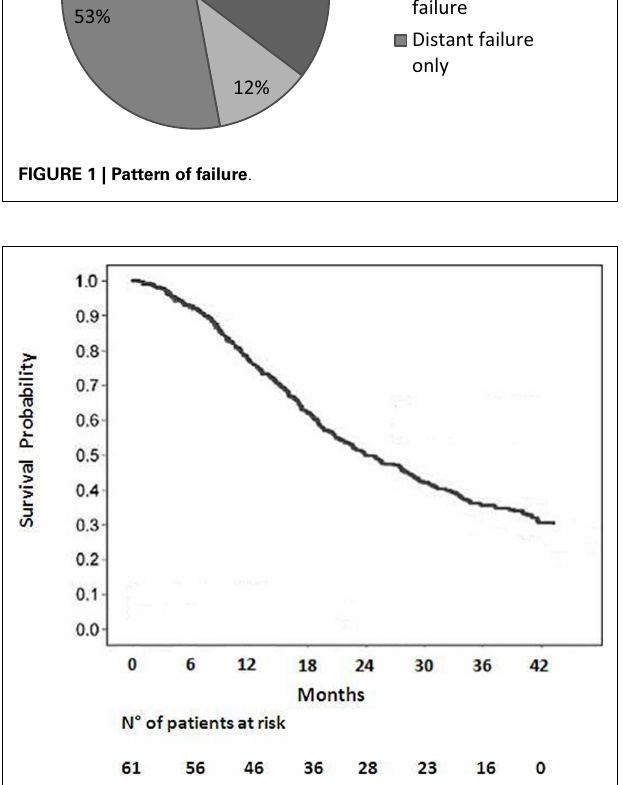
FIGURE 2 | Overall survival for all patients